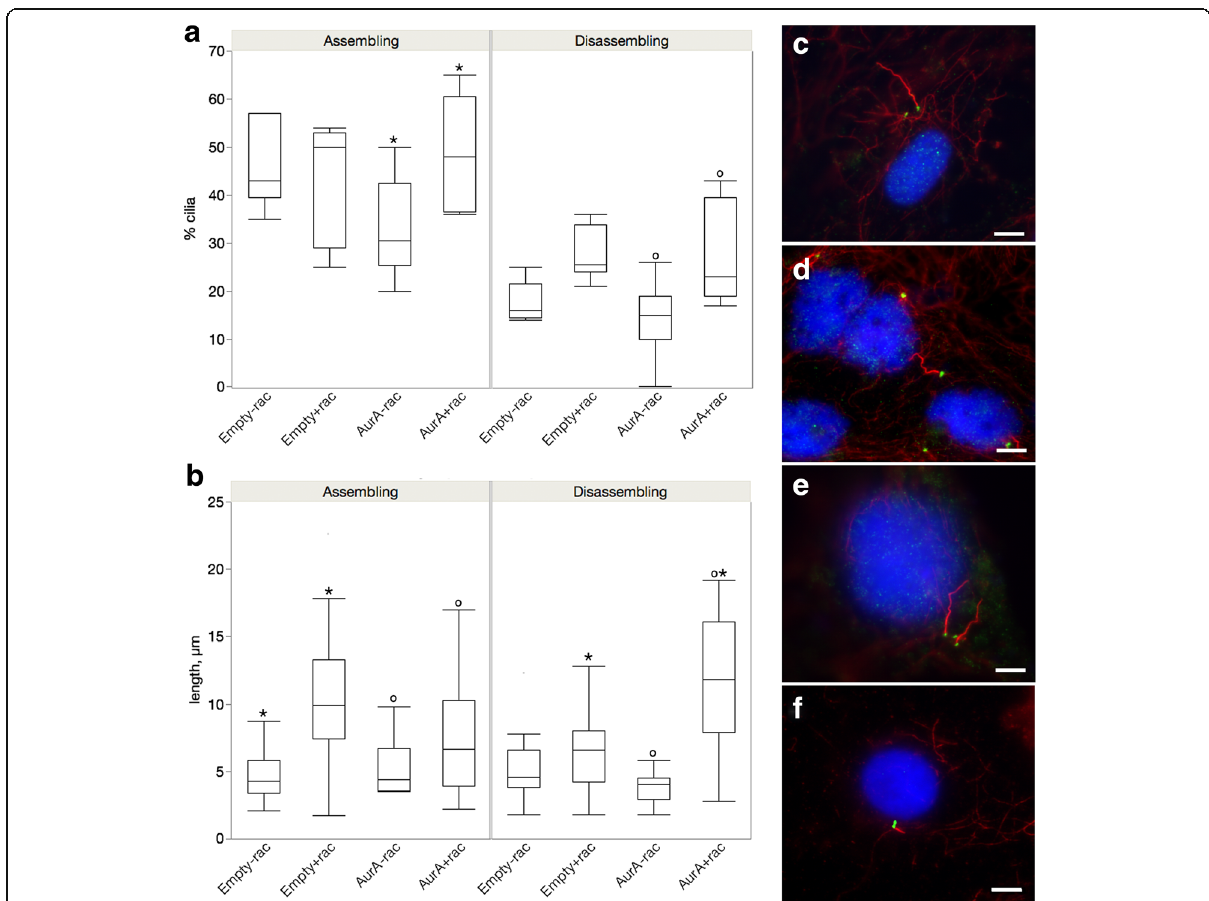
Fig. 5 Inhibition of Nek2 significantly lengthens cilia when cilia are assembling and disassembling. 10 μ M of the Nek2 inhibitor (rac-CCT250863) was added to the AurA transfections, cells were serum starved to stimulate cilia formation (assembling, left panels) followed by reintroduction of serum to induce cilia disassembly (disassembling, right panels). Cilia number ( a ) and length ( b ) were measured for a total of at least 300 cells. ( c-e ) show typical examples of long cilia in cells serum starved and exposed to the Nek2 inhibitor and stained for gamma tubulin (green), acetylated tubulin (red) and DNA (blue); ( f ) shows a control cell. Scale bar equals 10 μ m. The means for cilia number and length ± SEM are shown in Table